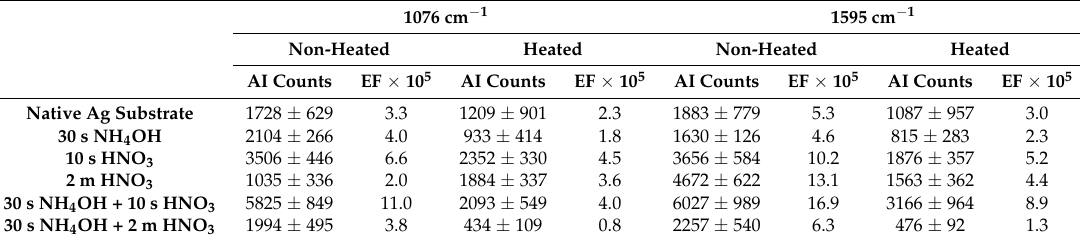
Table 4. SERS enhancements for the different test Ag substrates, in this study: As illustrated by the absolute intensities (AI, counts ± standard error of mean, n = 4) and enhancement factors (EF × 10 5 ) for the ~1076 cm − 1 and the ~1595 cm − 1 SERS peaks for 1 mM MBT as a function of chemical etching, with and without heat treatments using 514 nm laser